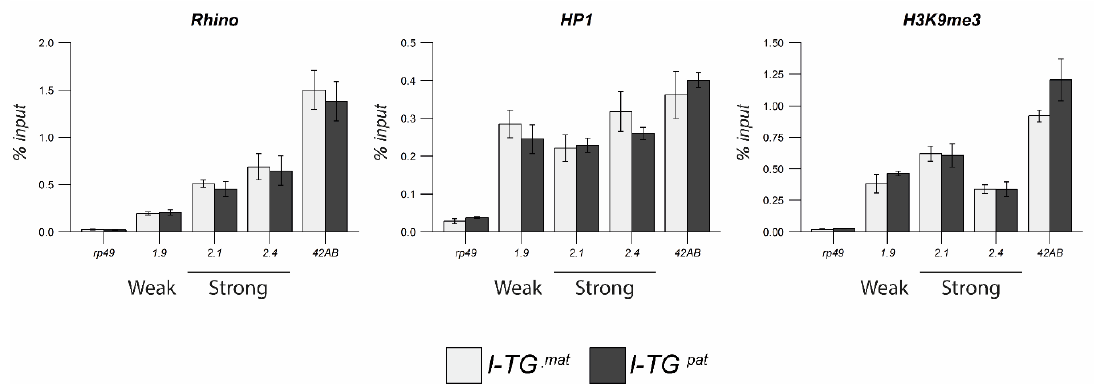
Figure 5. Chromatin structure of maternally- and paternally-inherited I-TG transgenes. HP1, H3K9me3, and Rhi occupancy at maternally- and paternally-inherited I-TG transgenes. The rp49 and 42AB regions are used as negative and positive controls, respectively.